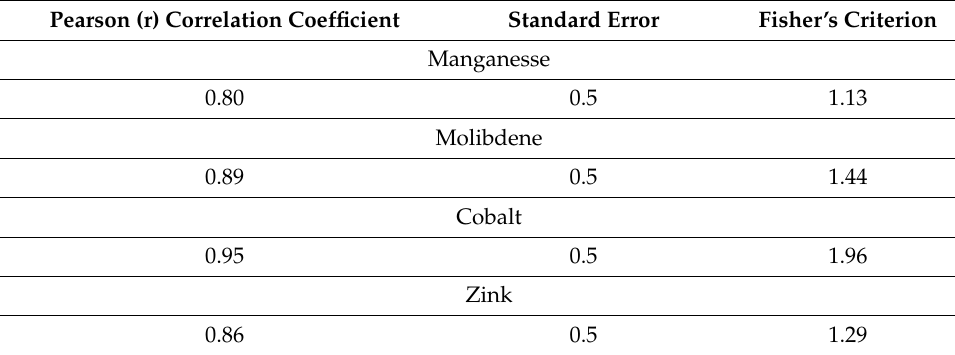
Table 6. Statistical treatment of soil and plants chemical analyses